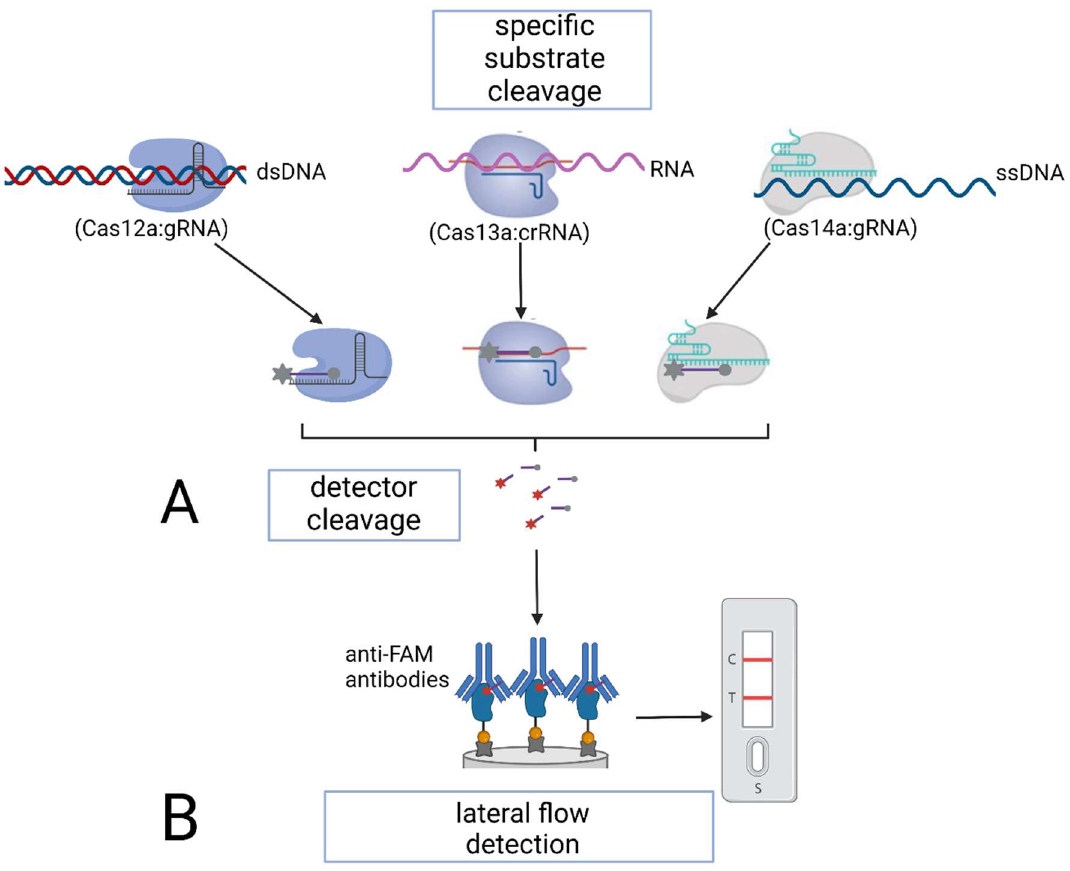
Figure 6. Specific nucleic acid detection using Cas12–Cas14 proteins: ( A ) via subsequent fluorescent detection; ( B ) via lateral flow detection.